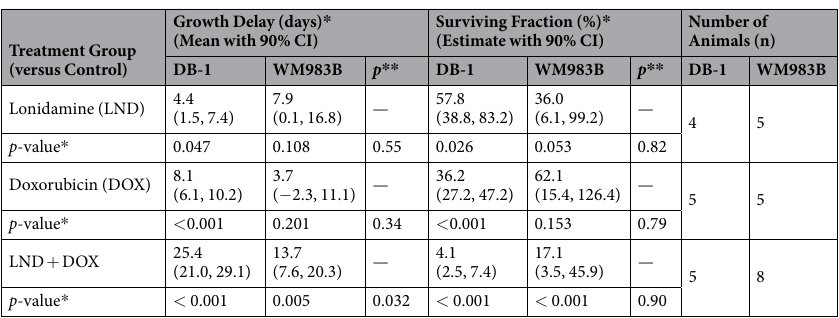
Growth Delay (days) * (Mean with 90% CI)